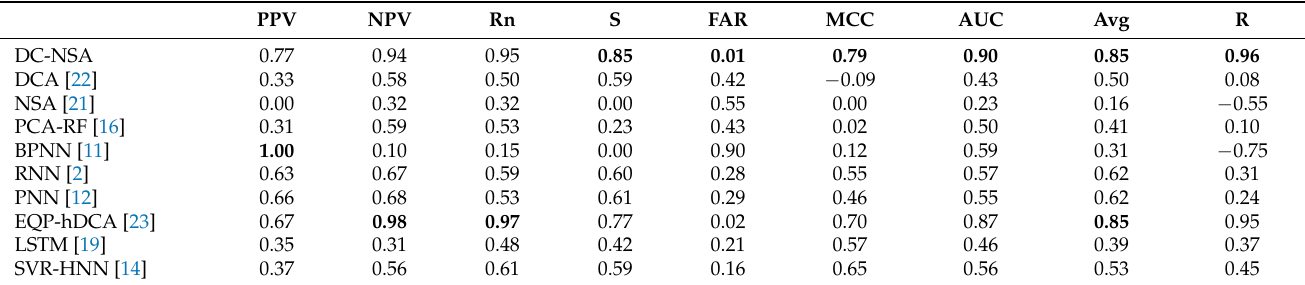
Table 8. Comparison between DC-NSA and other approaches when predicting DS4. The best results are in